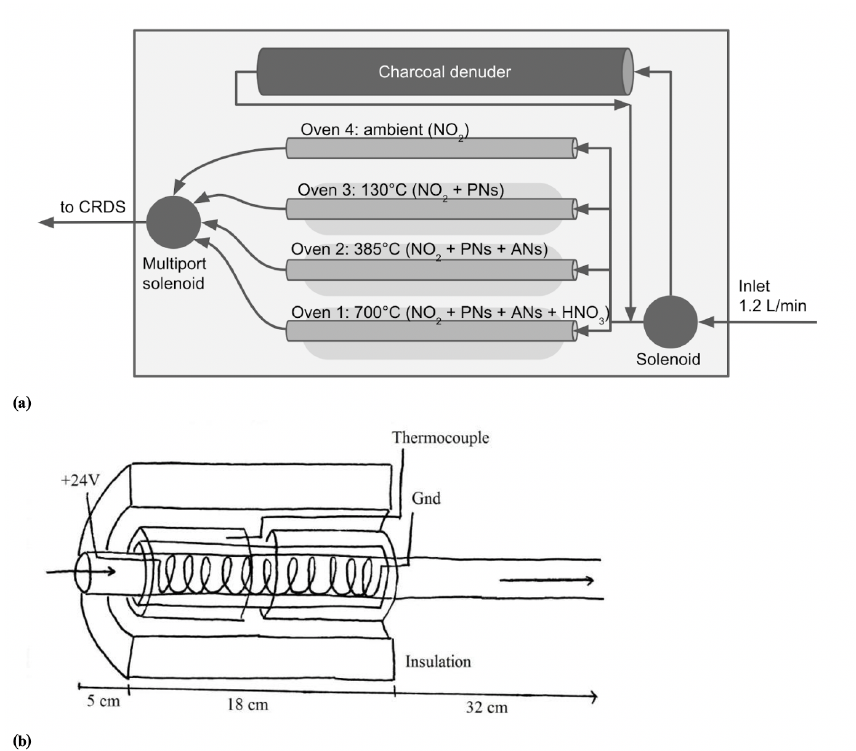
Figure 1. (a) Diagram of thermal-dissociation inlet flow path. The downstream valve is a Teflon-wetted six-solenoid multiport valve. (b) Oven design. Arrows indicate direction of airflow. A photograph of the inlet box is shown in the Supplement, Fig.